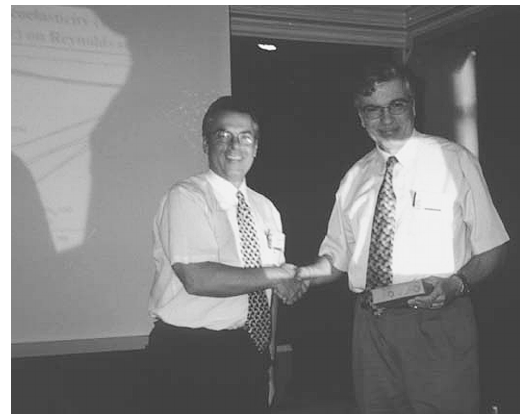
Figure 3 (right): The Chair of HSR 2004,